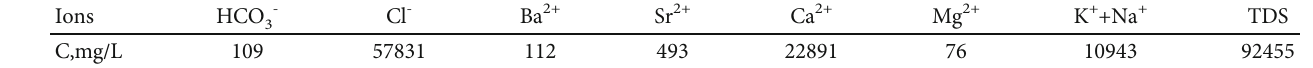
Table 1: Composition of the formation water.